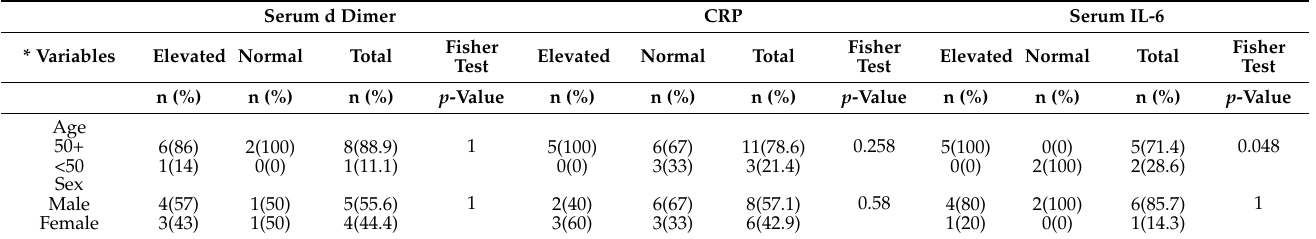
Table 8. Comparison of various for PNS manifestation, demographics, severity and fatality by serum markers. Serum d Dimer CRP Serum